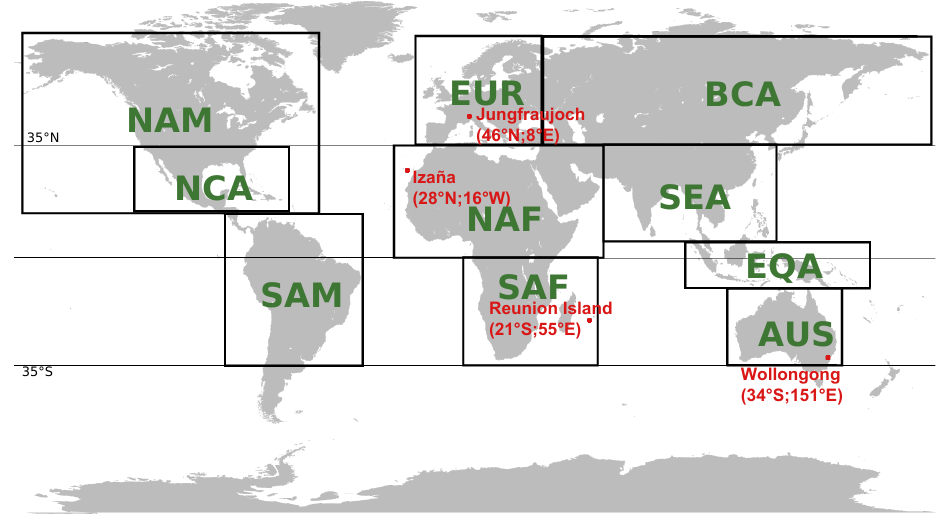
Figure 6. Locations of the four ground-based FTIR measurements sites (Jungfraujoch, Izaña, Reunion Island and Wollongong) and map of the 10 regions used in this study: NAM: northern America, NCA: north-central America, SAM: South America, EUR: Europe, NAF: northern Africa, SAF: southern Africa, BCA: boreal Central Asia, SEA: Southeast Asia, EQA: equatorial Asia, AUS: Australia.